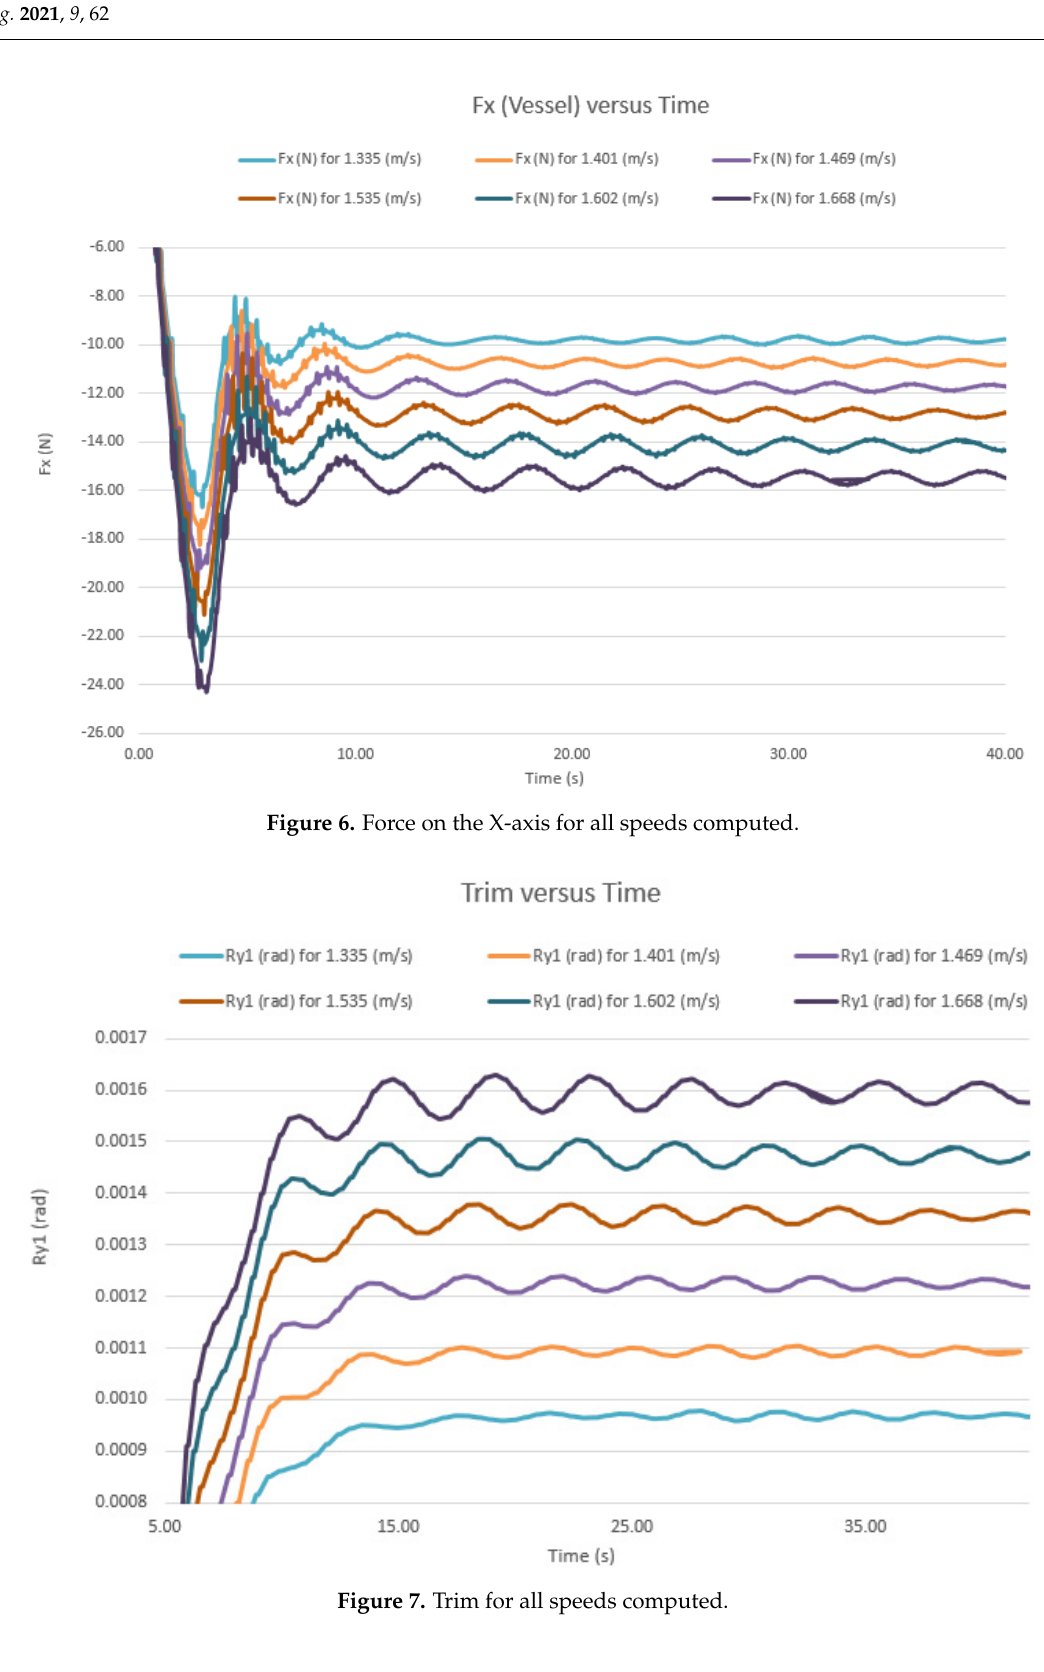
Figure 8. Sinkage for all speeds computed. In Figure 9, the wave height generated for all six speeds in SHIPFLOW and pro- cessed in Tecplot is presented. As the speed increases, it can be seen that as the wave height increases, the wave component is also more visible.